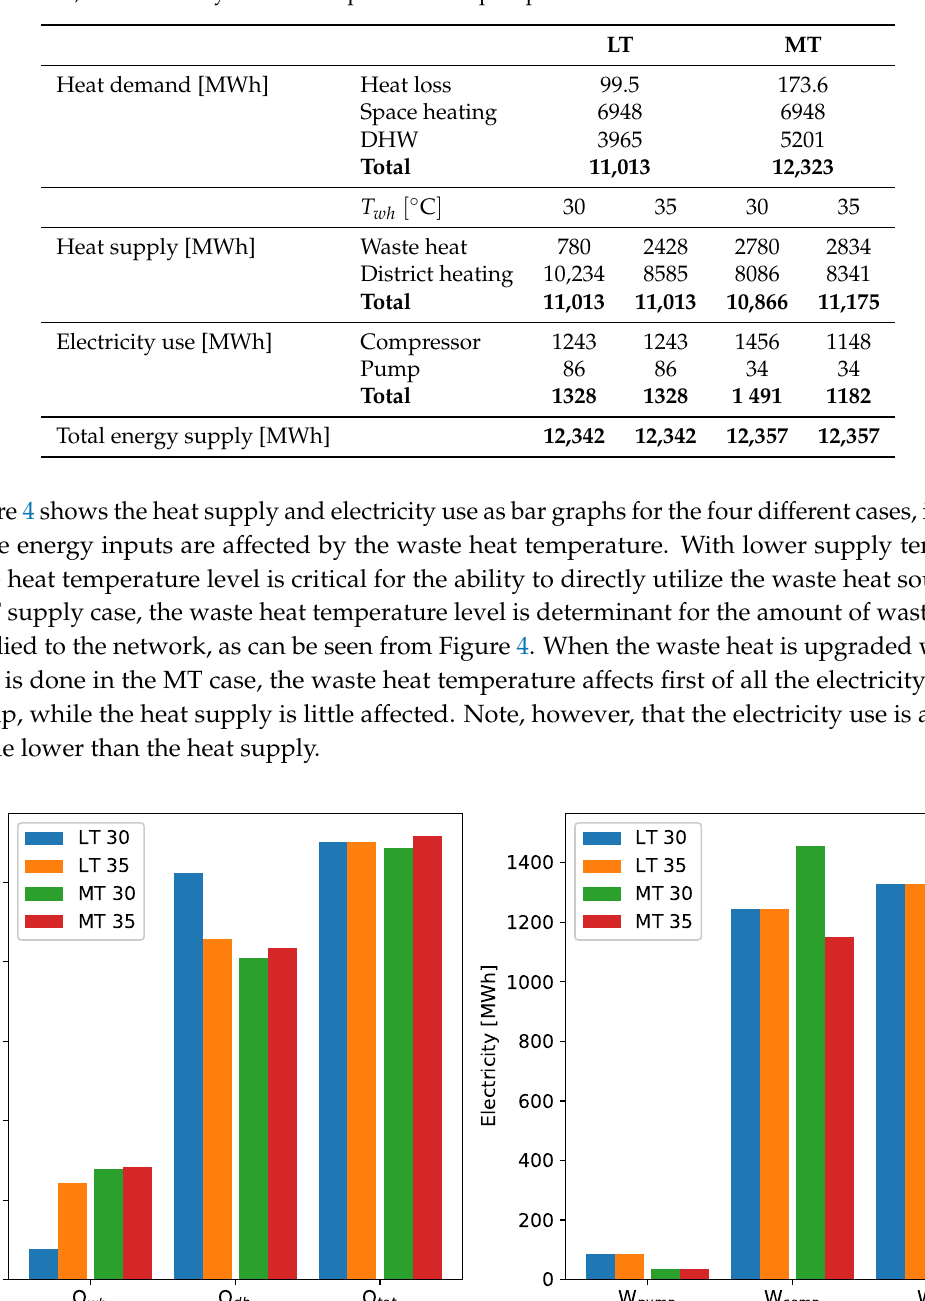
Table 4. The total annual energy in- and outputs for the LT and MT cases, for the two different waste heat temperatures: total heat demand for space and DHW heating as well as heat losses; heat supply from waste heat and DH; and electricity use for compressors and pumps.